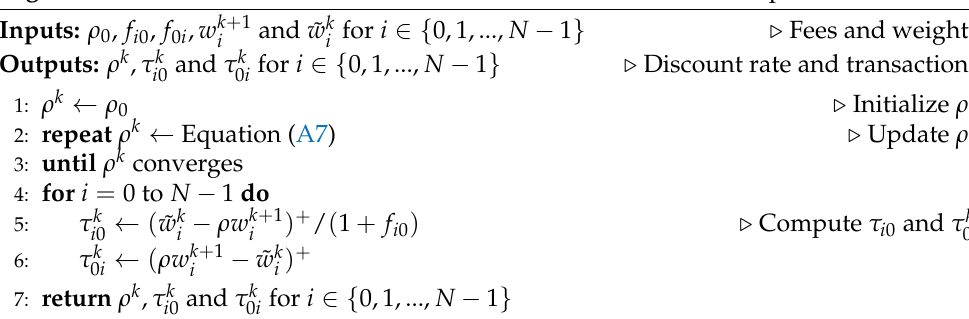
Algorithm 2 Solution for the constrained case of the fee minimization problem